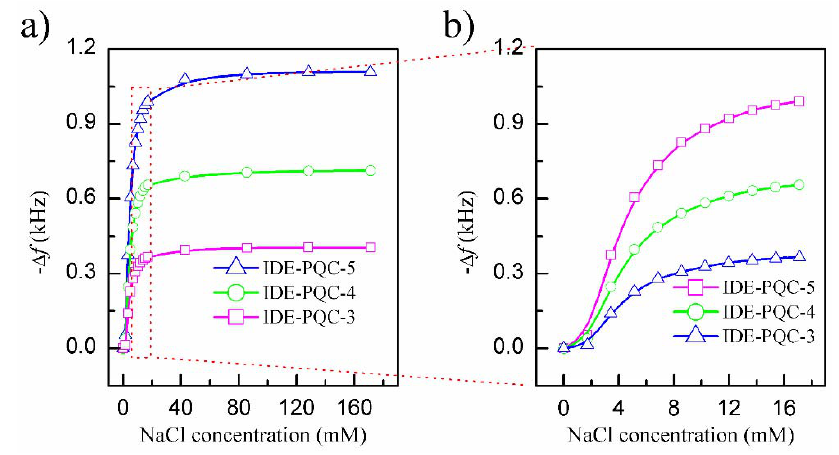
Figure 5. Frequency shifts of IDE-PQC sensor at different NaCl solution concentration.